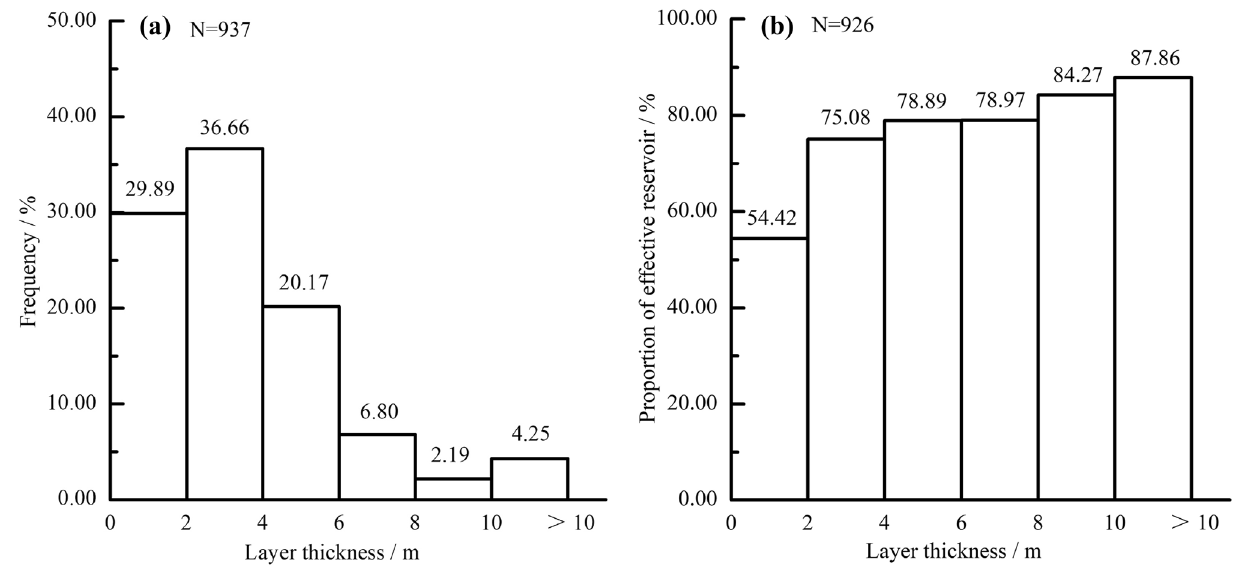
Fig. 7 Distribution characteristics of the single-layer thickness of different sand bodies in the Dawangzhuang area of the Raoyang sag ( a ) and the proportion of effective reservoirs under sand bodies with different thicknesses ( b